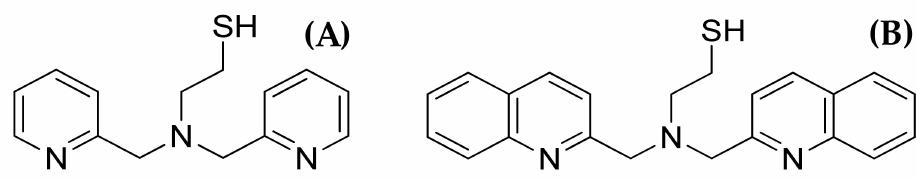
Figure 1. The two tridentate thiol ligands used in this study: ( A ) L 1 H and ( B ) L 2 H. After functionalization of AuNPs with the two thiol ligands and radiolabeling with [ 99m Tc][Tc(H 2 O) 3 (CO) 3 ] + , in vitro stability in human serum and in cysteine and